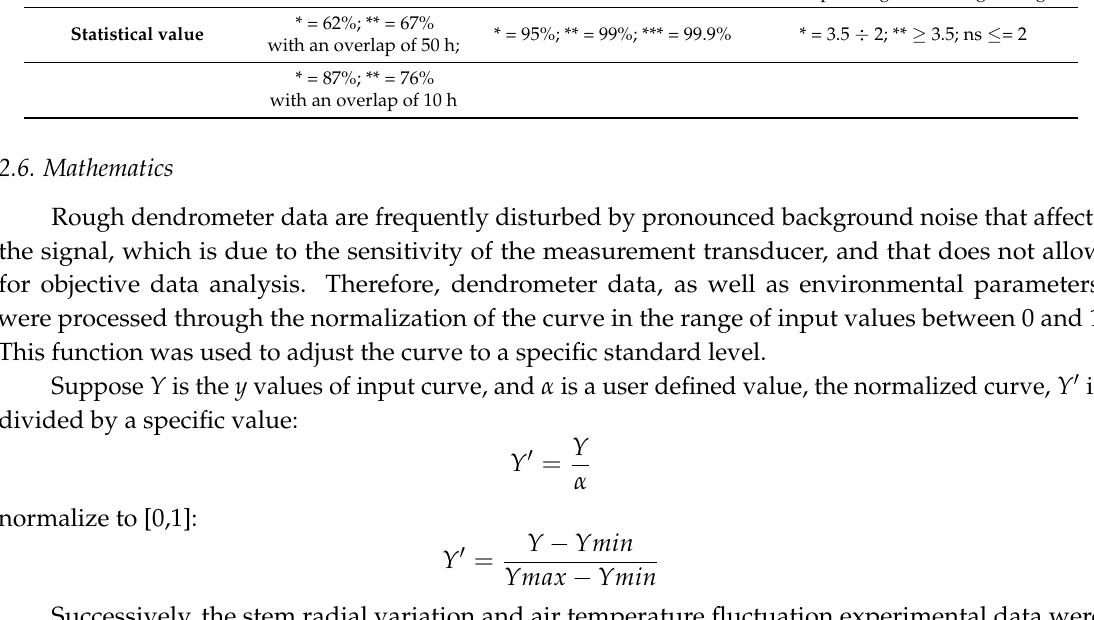
Table 3. Statistical tools of analysis of time series in the cross-timing procedure using Time Series Analysis Programme, TSAP-Win software platform (Rinntech). Statistical significance of the Gleichlaeufigkeit (Glk) values (GSL) and the Baillie–Pilcher t-value (TVBP), used as a statistical tool for comparing and cross-timing of time series, were reported with values of statistical significance (*, **, *** = < 0.05, < 0.01, < 0.001 p -level, respectively; ns = not significant). Statistical Tool Glk GSL TVBP Tool for comparing and cross-timing of time series. It determines the degree of correlation between curves. Statistical significance of the This method eliminates Glk significance for the low-frequency variations in the time Glk-value series, as each value is divided by the corresponding 5 h moving average Statistical